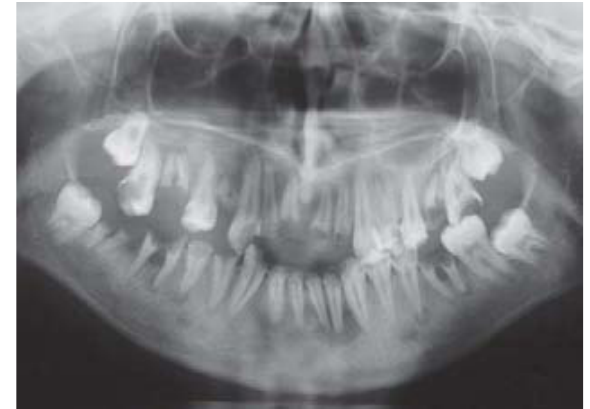
Figure 2- Preoperative panoramic radiograph showing teeth with periapical